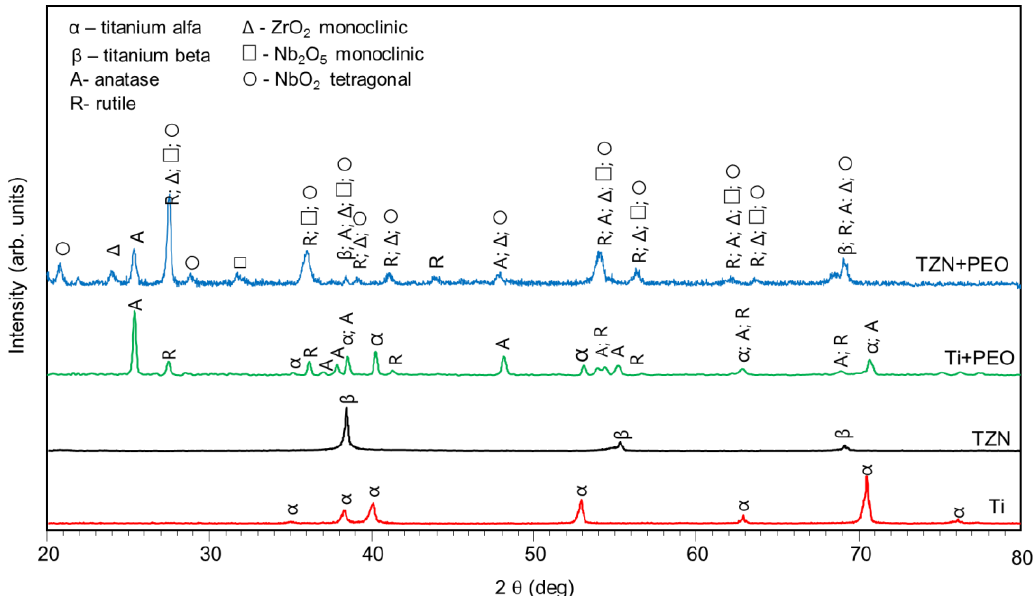
Table 3. Estimation of the crystalline phase content (wt %) of the PEO coatings from the XRD analysis . Sample Type